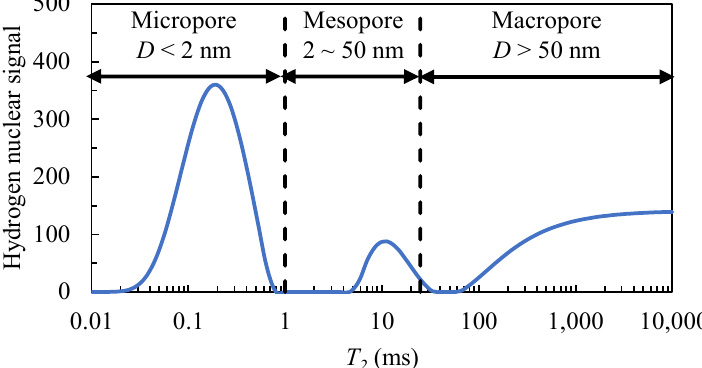
Figure 3. Relationship between T 2 distribution and pore size distribution of shale. According to Equation (6), the T 2 spectrum of shale can be divided into three parts: T 2 < 1 ms, 1 ms < T 2 < 25 ms, and T 2 > 25 ms, representing the fluids containing hydrogen in micropores, mesopores, and macropores, respectively.